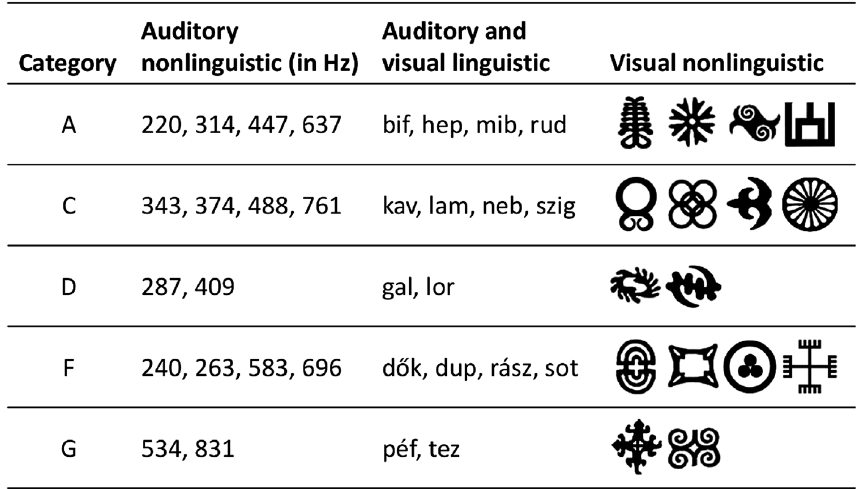
Figure 2. Stimulus sets in different conditions by modality and domain. Stimuli in each condition are classified into categories (A, C, D, F, and G). The rules of the grammar are defined on these categories.